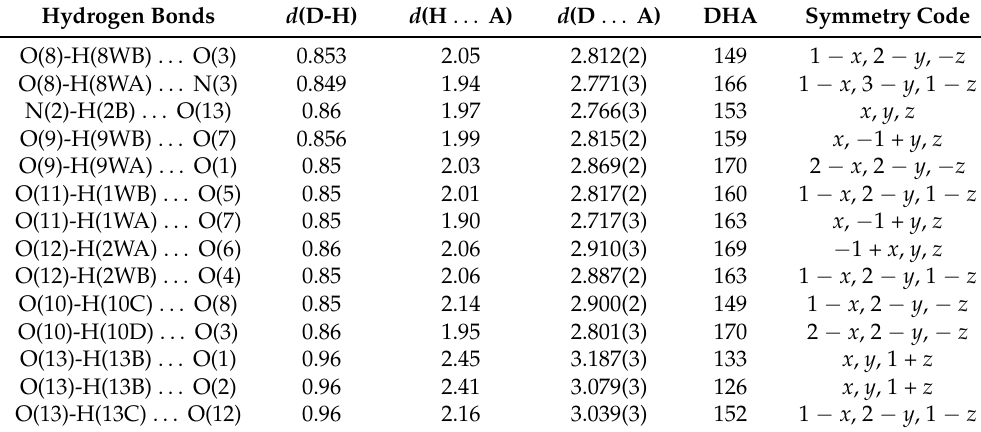
Table 2. The lengths (Å) and angles ( ◦ ) of hydrogen bonds for 1 .